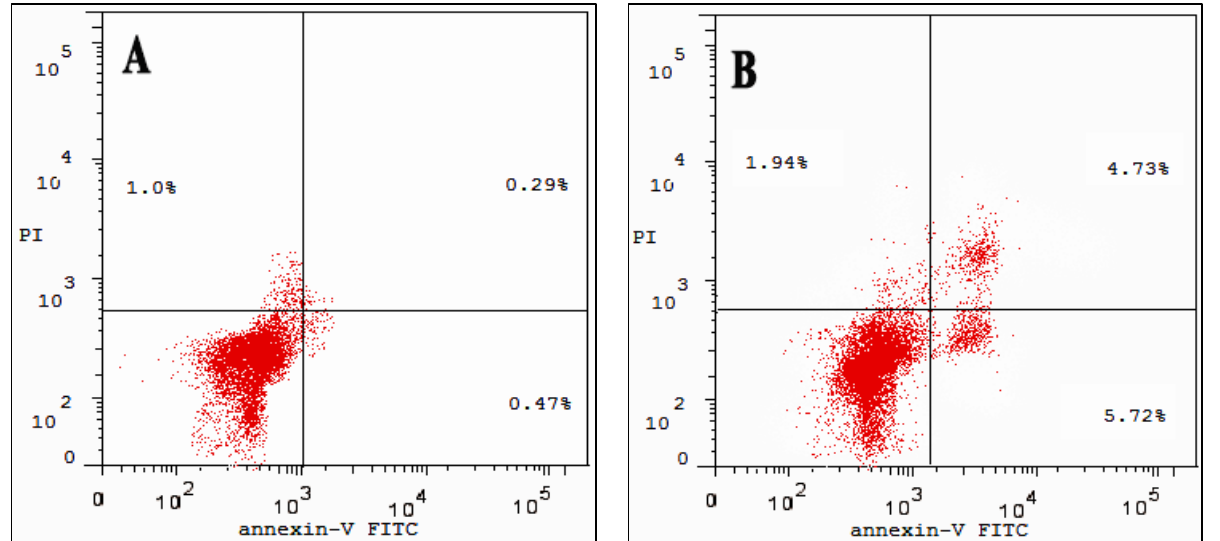
Figure 10. ( A ) Apoptosis analysis for MCF-7 (control); ( B ) apoptosis analysis for MCF-7 cancer cell line was treated with CA-BSA-NPs.